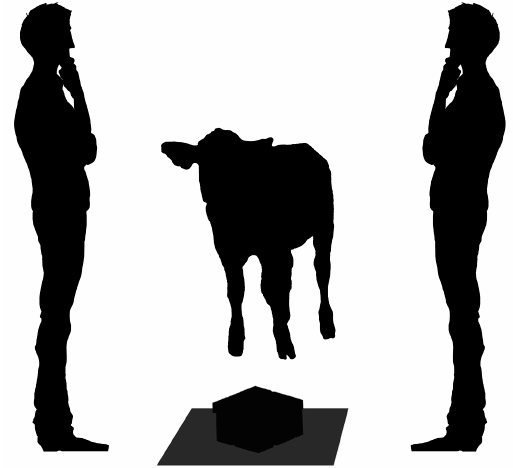
Figure 1. Schematic illustration of the experimental setting.